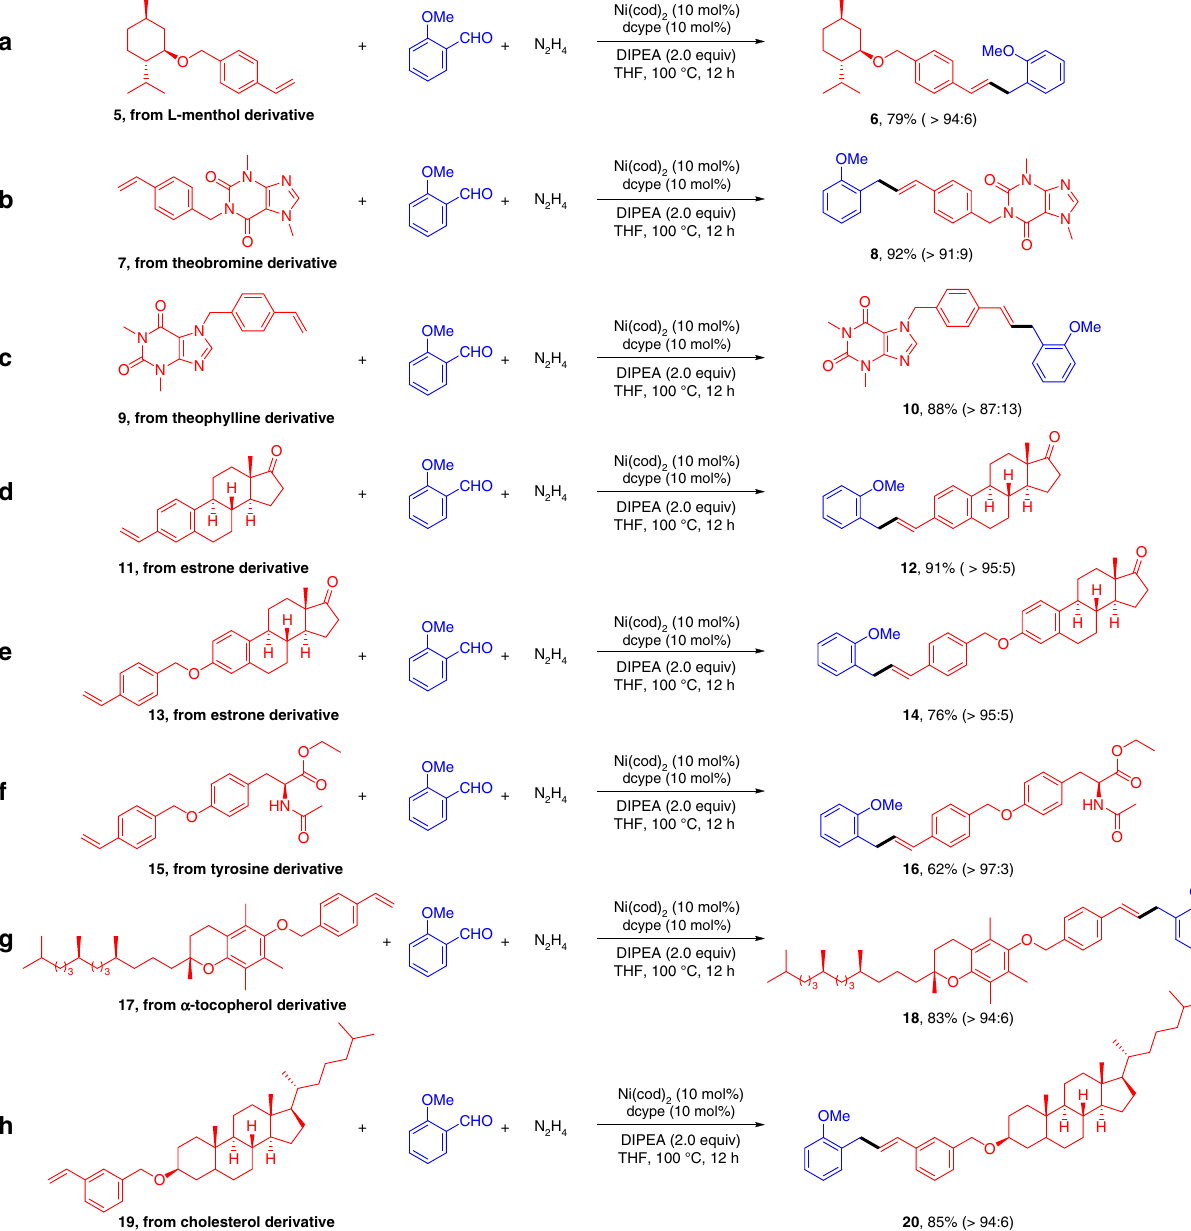
Fig. 3 Functionalization of naturally and pharmaceutically important derivatives. a Regioselective Heck coupling of L-Menthol derivative; b Regioselective Heck coupling of Theobromine derivative; c Regioselective Heck coupling of Theophylline derivative; d Regioselective Heck coupling of vinyl Estrone derivative; e Regioselective Heck coupling of Estrone derivative; f Regioselective Heck coupling of Tyrosine derivative; g Regioselective Heck coupling of α -Tocopherol derivative; h Regioselective Heck coupling of Cholesterol